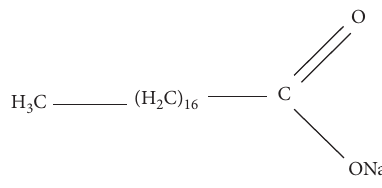
Figure 12: Sodium hexadecyl